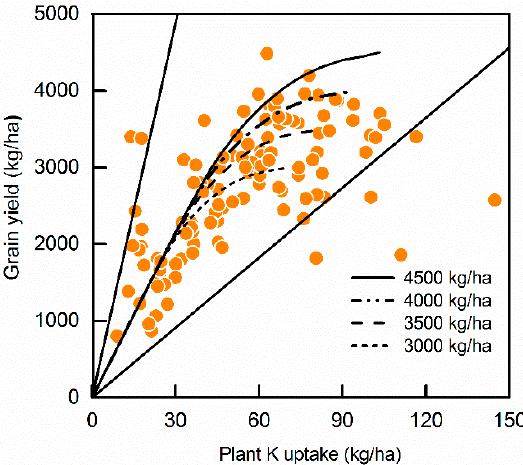
Figure 4. Application of the QUEFTS model to simulate the balanced plant N, P, and K uptake under different yield potentials (3000 kg/ha to 4500 kg/ha) for soybean.